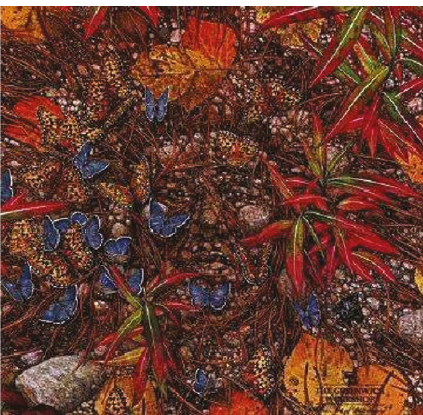
Figure 4: What is this? leaves or stones?